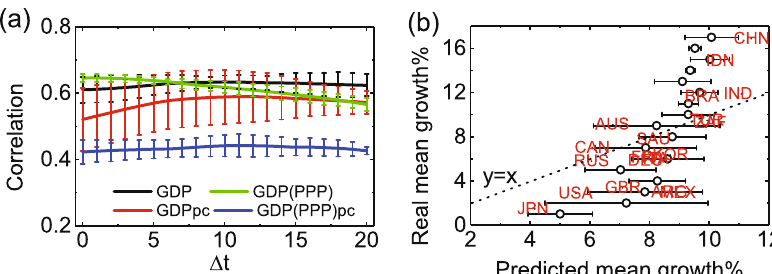
Fig. 5 Predicting some representative economic indexes. a The correlation ρ between future economic index and the current global trade competitiveness ( GTC ). b Growth in GDP per capita(GDPpc) is predicted between 2000 and 2010. We give the range prediction under each bin of real growth. The red labels are the prediction of G20